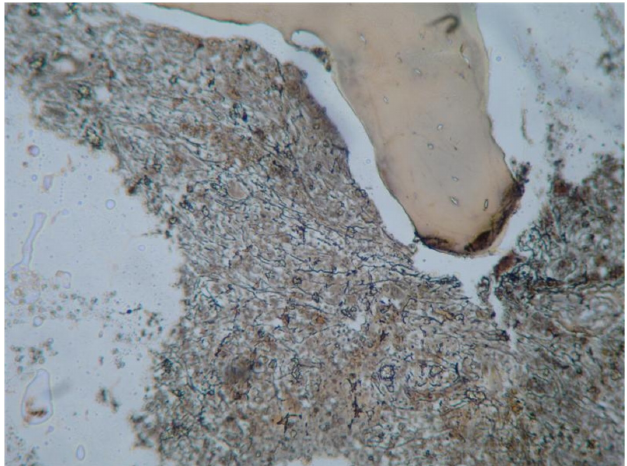
FIGURE 1B - Histological section of BMB stained by Gomori silver solution, 100 x magnification. The fibers are stained in gray. This sample presents reticulin network graded as